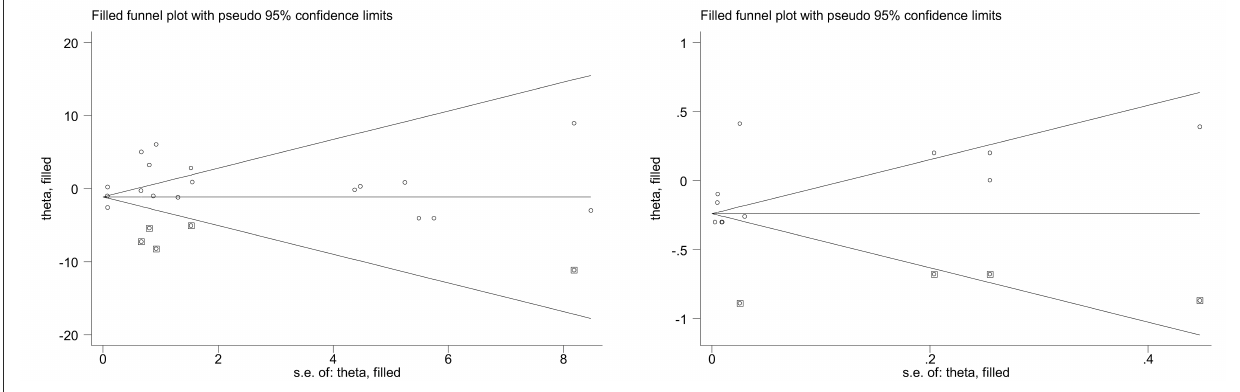
FIGURE3 Funnel plots of four assessment scales for monoclonal antibodies against A β vis-à-vis placebo in the treatment of mild or moderate Alzheimer’s disease.